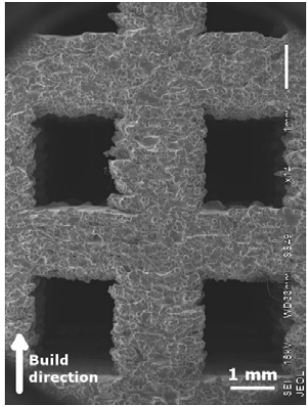
Figure 11. Better-quality surfaces of horizontal struts produced with the modified scan strategy (1.5 mm strut).